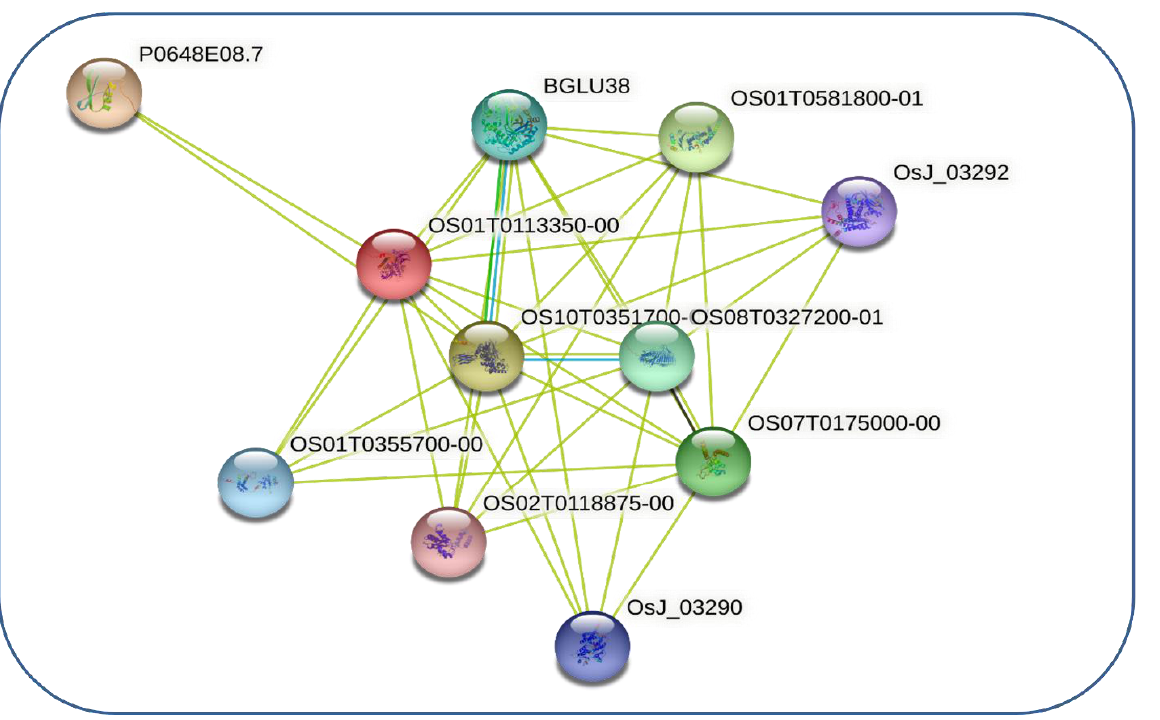
Figure 4. Interactive network of OsTLP1 protein.